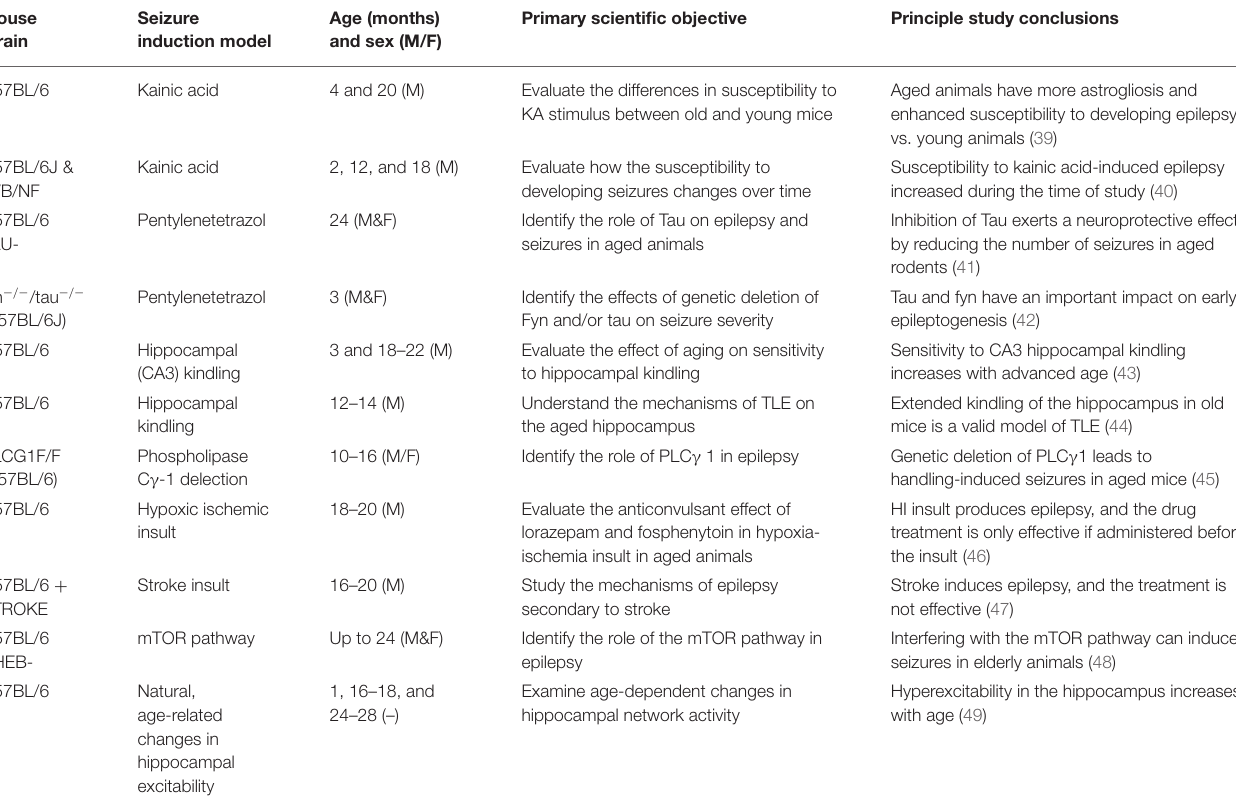
TABLE 1 | Primary pre-clinical studies of epilepsy in aged